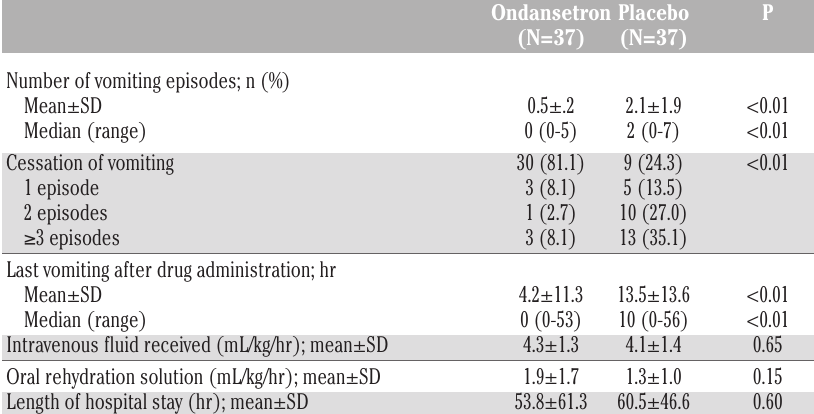
Table 3. Outcomes